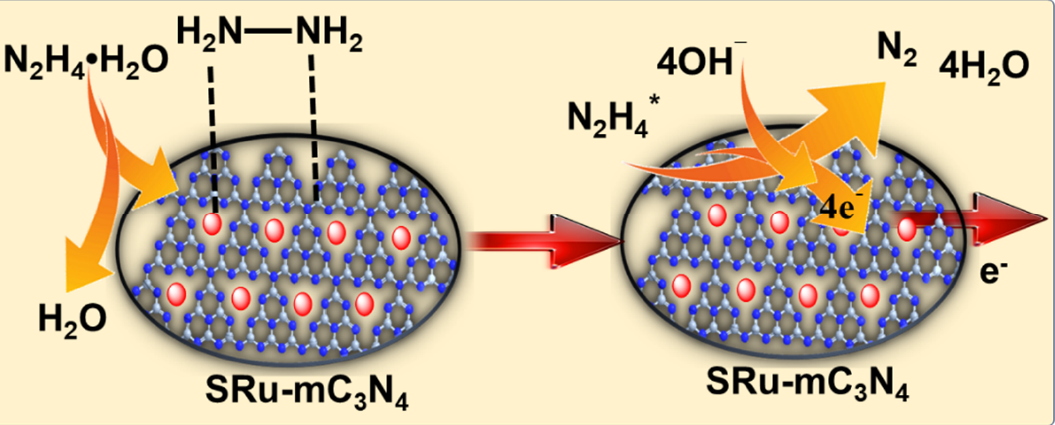
Figure 6. Schematic demonstration of steps in electrochemical hydrazine oxidation at SRu-mC 3 N 4 anode interface.